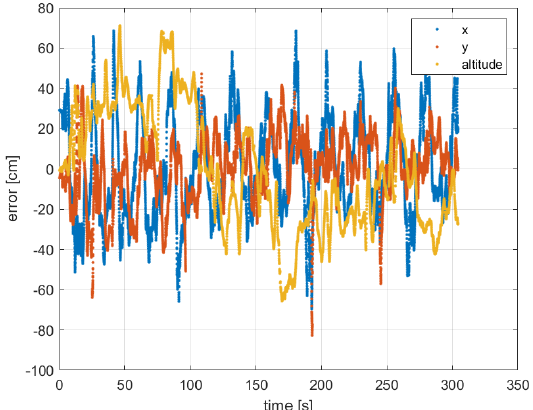
Figure 6. Errors on the UWB position estimates in the EKF2 case.